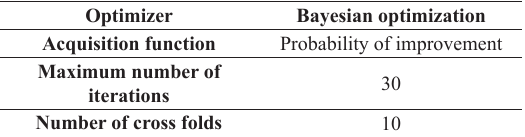
Table 1. Primary selected optimal parameters of OMLR methods during the training stage.